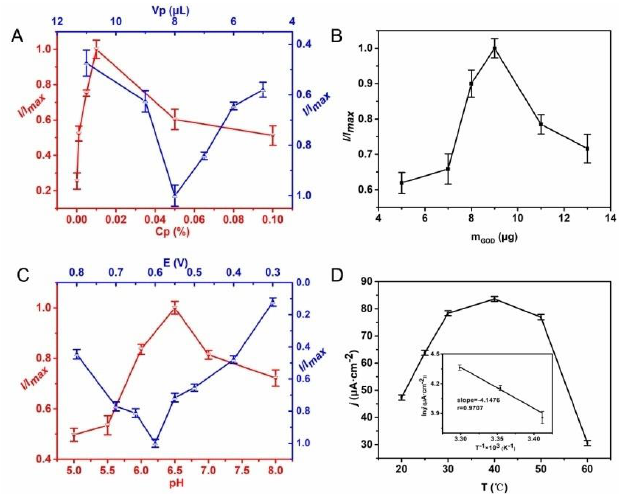
Figure 4. ( A ) Effect of the polymer concentration (red line) and the volume of casting solution (blue line). ( B ) Effect of the amount of GOx. ( C ) Effect of pH (red line) and applied potential (blue line).